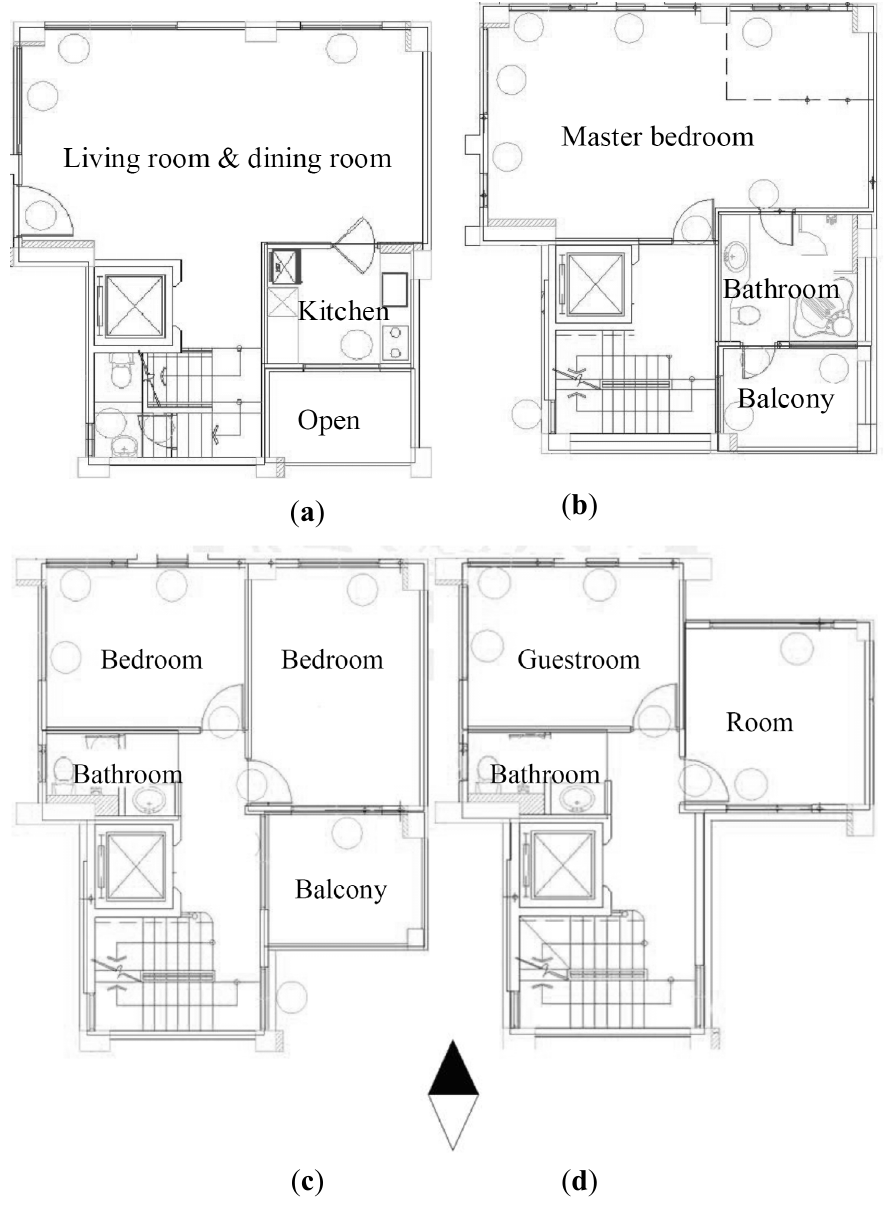
Figure 2. Floor plans of the main simulation target (not to scale): ( a ) 1st floor; ( b ) 2nd floor; ( c ) 3rd floor; ( d ) 4th